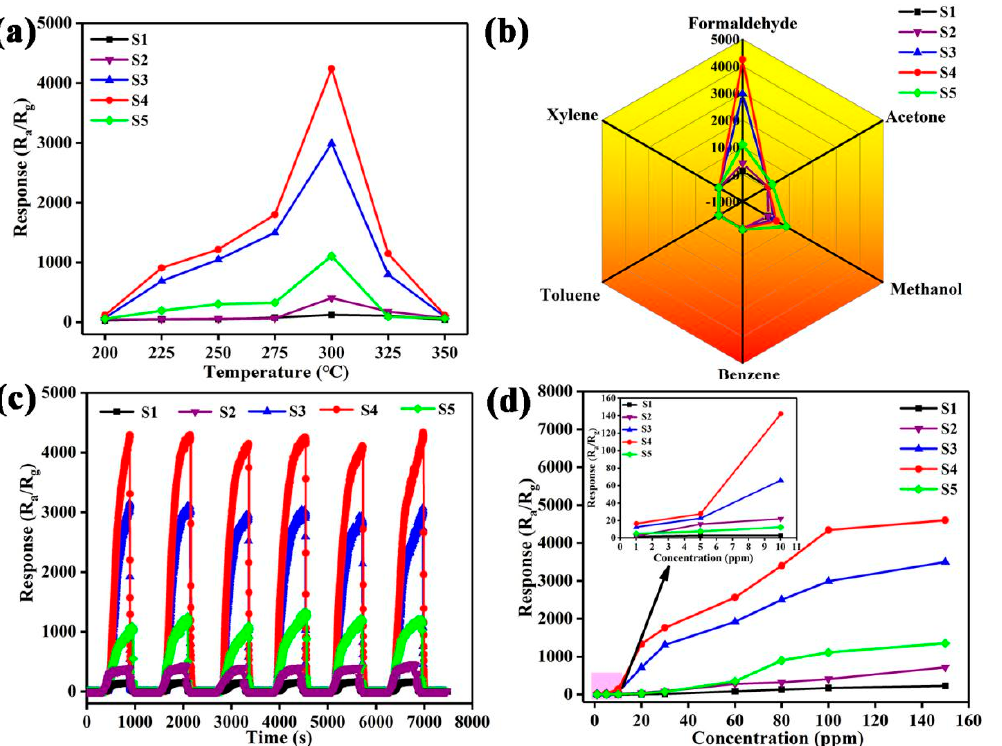
Figure 7. Sensing performances of S1–S5: ( a ) Response to 100 ppm formaldehyde in the temperature range of 200–350 °C. ( b ) Response to 100 ppm of interfering analytes at 300 °C. ( c ) Six-cycle dynamic formaldehyde sensing characteristics at 300 °C. ( d ) Response toward different concentration of formaldehyde.